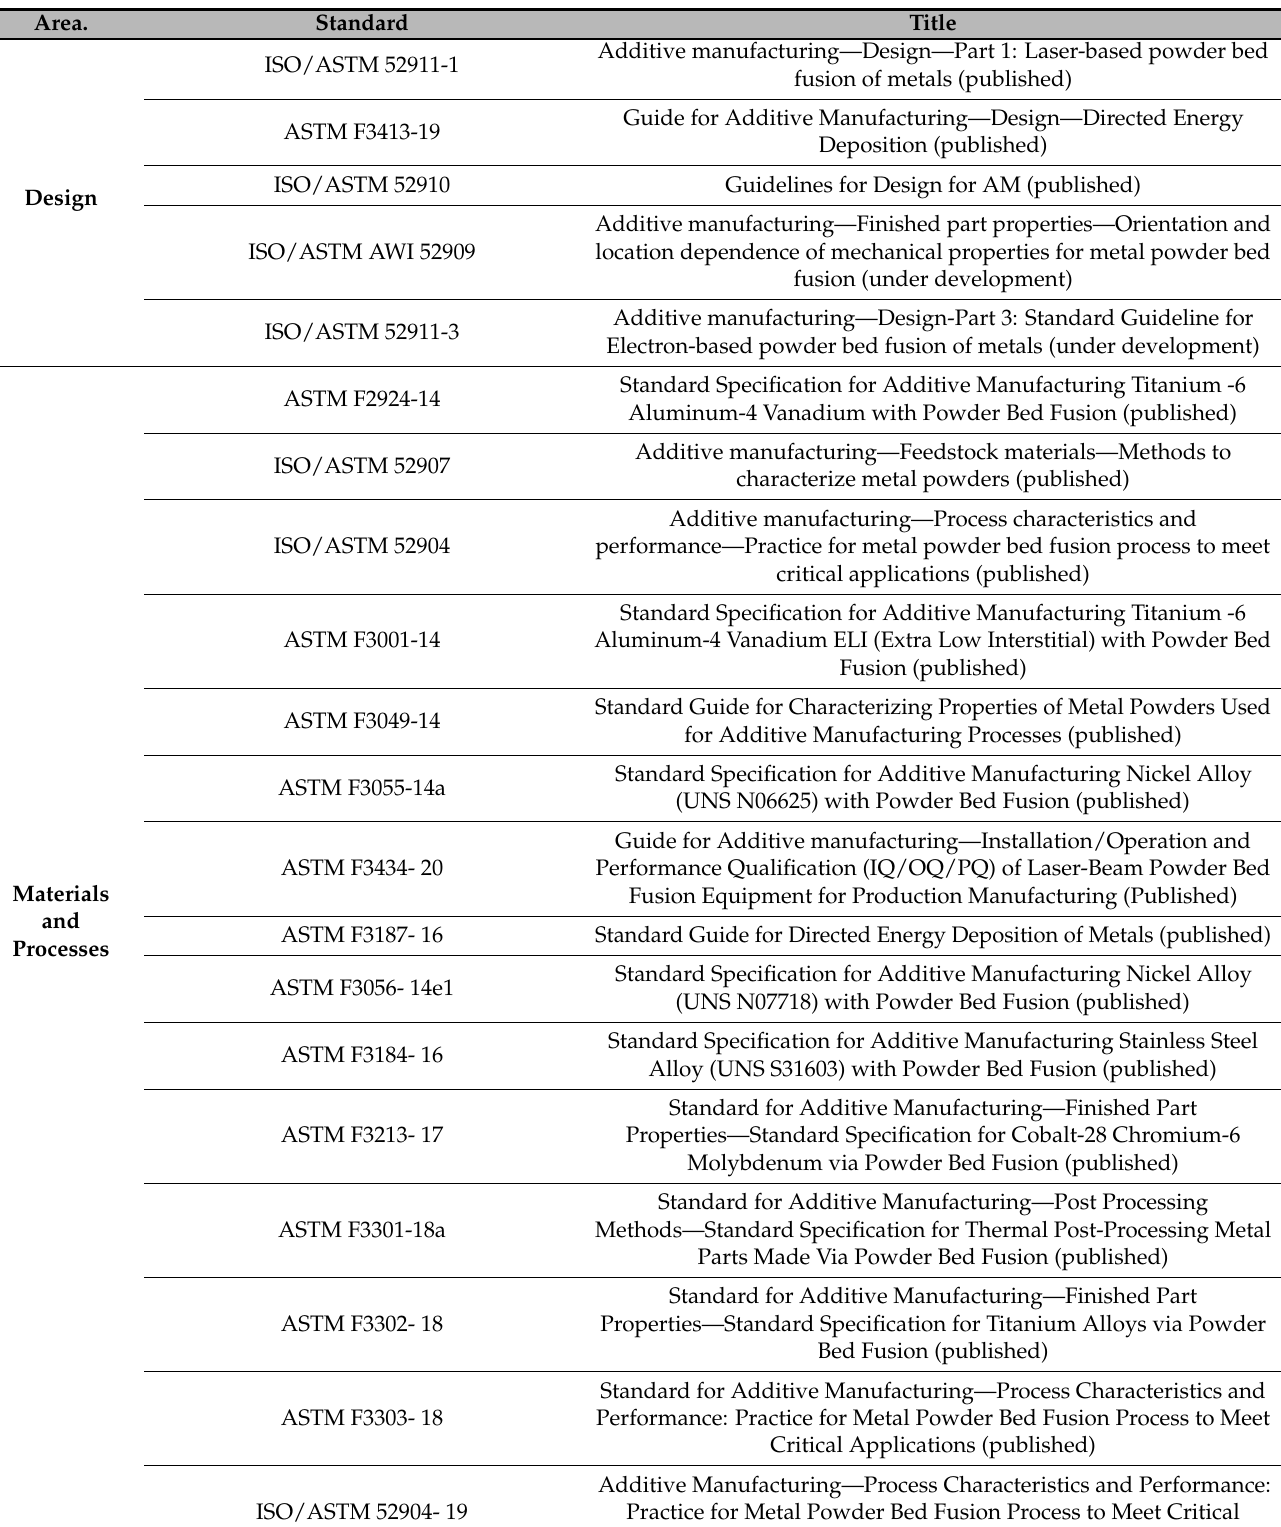
Table A1. 40 identified current and under development standards for metal AM.